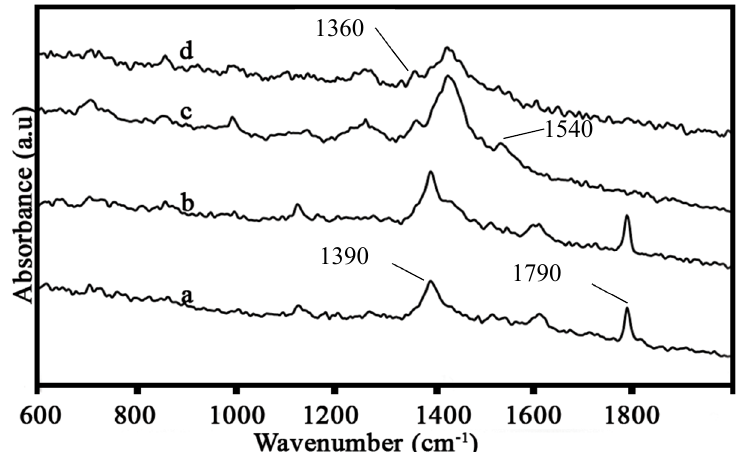
Figure 1. Raman spectra of (a) neat polyimide (PI) and PI containing (b) 1 wt.% (c) 10 wt.% and (d) 30 wt.% graphene.